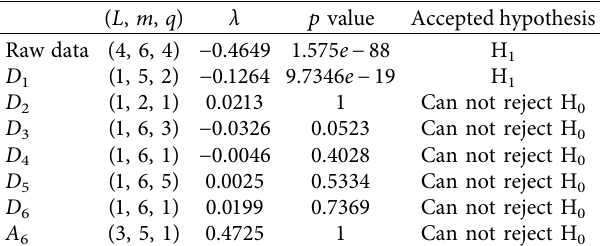
Table 2: Chaos test results for the agriculture indexes returns. ( L , m , q )